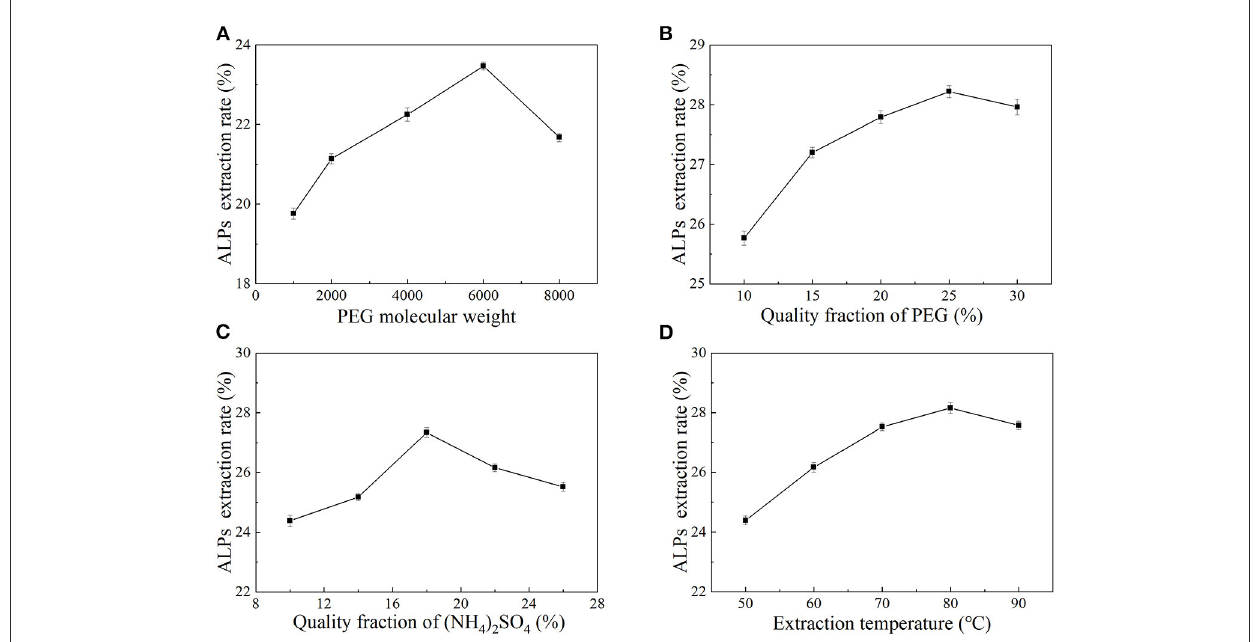
FIGURE1 The effects of PEG molecular weight (A) , PEG quality fraction (B) , (NH 4 ) 2 SO 4 quality fraction (C) , and extraction temperature (D) on the extraction rate of ALPs.